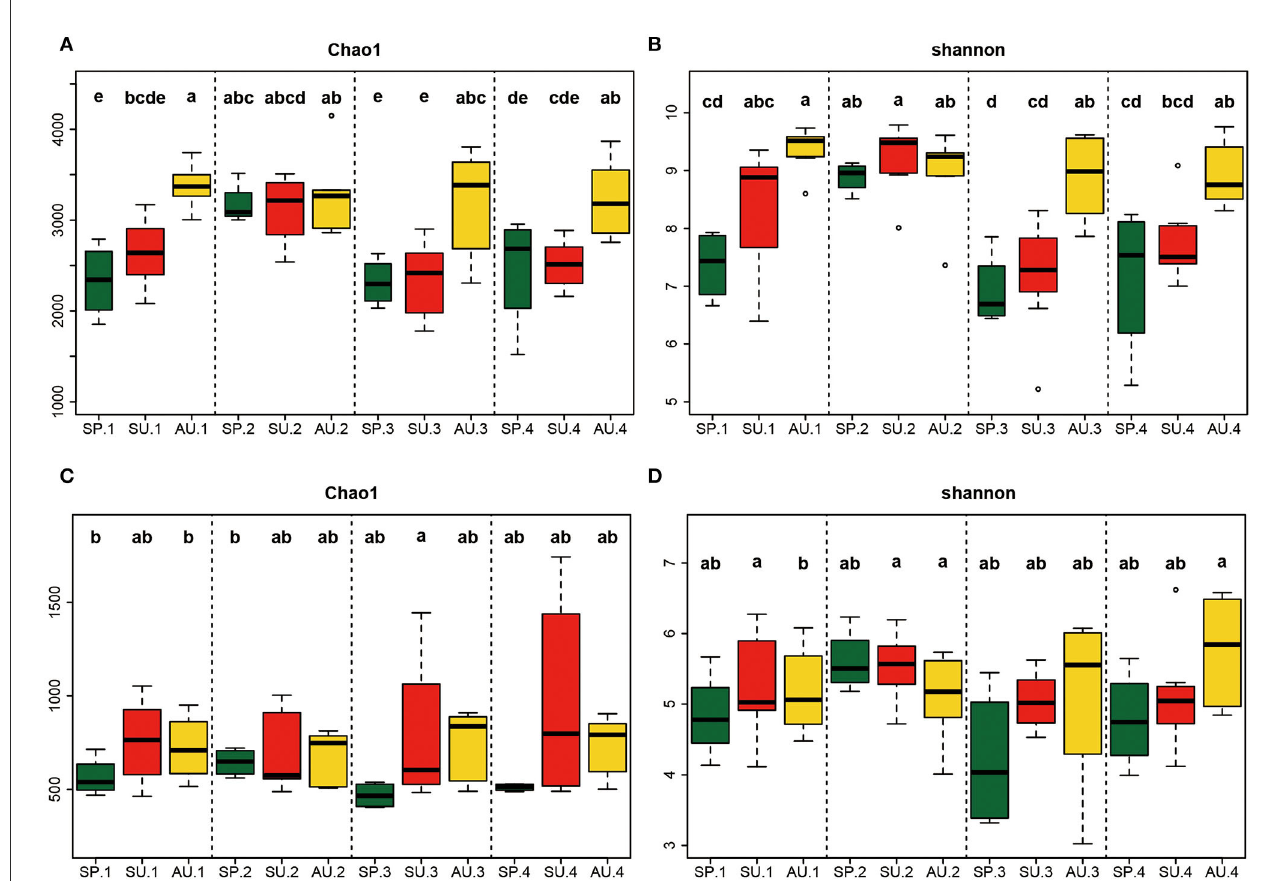
FIGURE2 Alpha-diversity of microorganisms during the growing stages of American ginseng. Chao1 of bacteria (A) , Shannon of bacteria (B) , Chao1 of fungi (C) , and Shannon of fungi (D) . Thick horizontal bars show the median. The upper and lower “hinges” correspond to the 25th and 75th percentiles, and whiskers extend from the hinge to the highest (or lowest) value that is within 1.5 × interquartile range (IQR) of the hinge. Boxes that do not share the same letter indicate a significant difference ( P < 0.05, according to Duncan’s multiple range